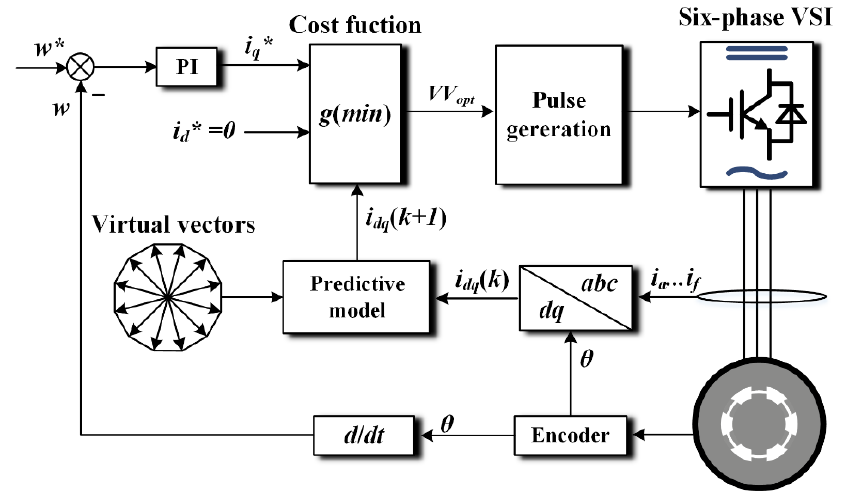
Figure 4. Control scheme of VV-MPC.